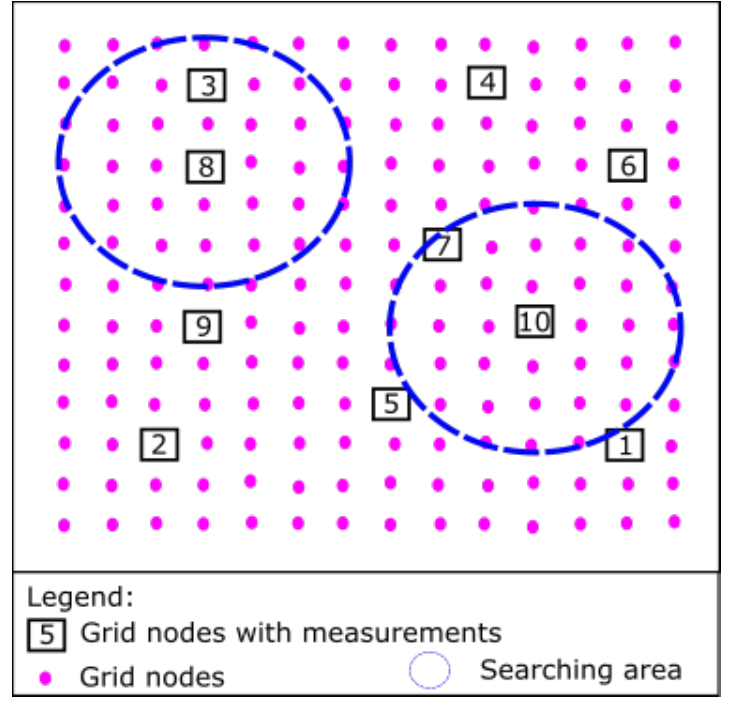
Figure 7. Radii of coverage of the MSM (modified from [3]).